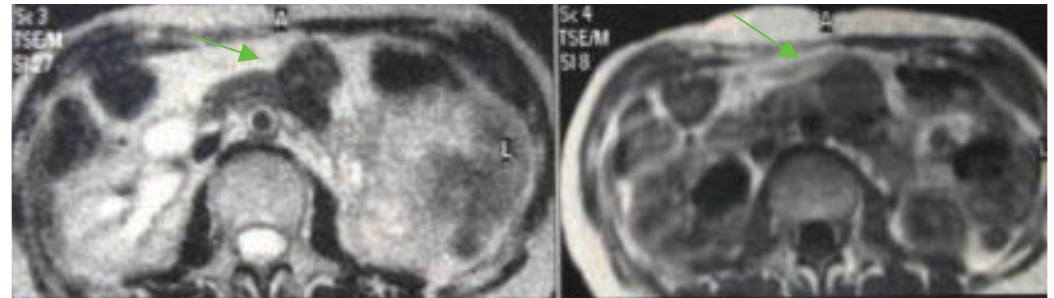
Figure 4. Abdominal MRI showing a peripancreatic mass (arrows).